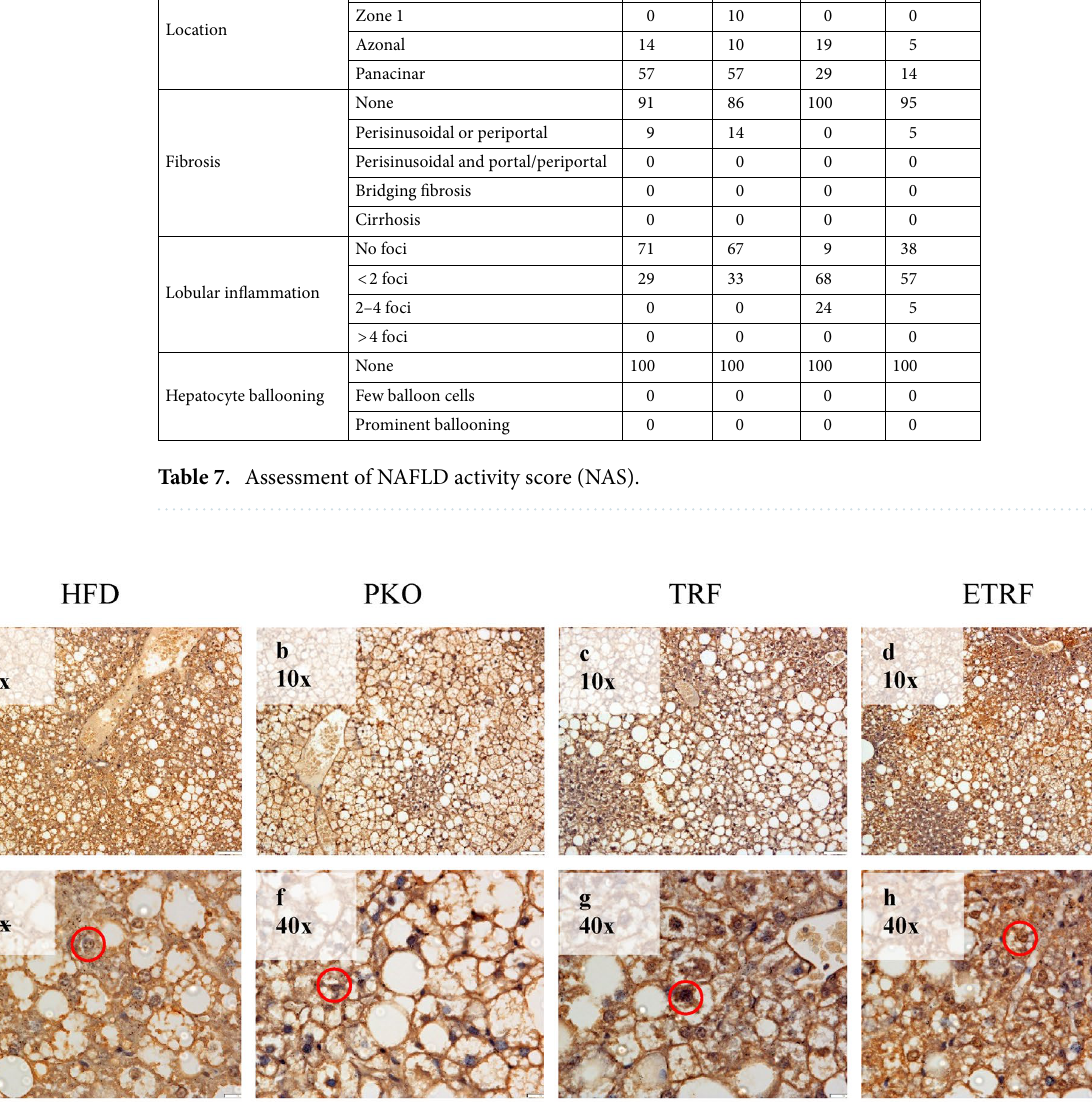
Figure 3. The effect of HFD, PKO, TRF and ETRF on Farnesoid-X Receptor (fxr) expression based on immunohistochemistry (IHC). Representative histology images of IHC staining of liver fxr in HFD ( a , f ), PKO ( b , g ), TRF ( c , g ) and ETRF ( d , h ) at 10 × ( a – d ) and 40 × ( e – h ) magnifications. Expression of fxr is demarcated by a red circle where expression was assessed based on positive cells identified by the intensity of intracellular chromogen (brown) staining and number of hepatocytes expressing the staining which could be observed at 40 ×